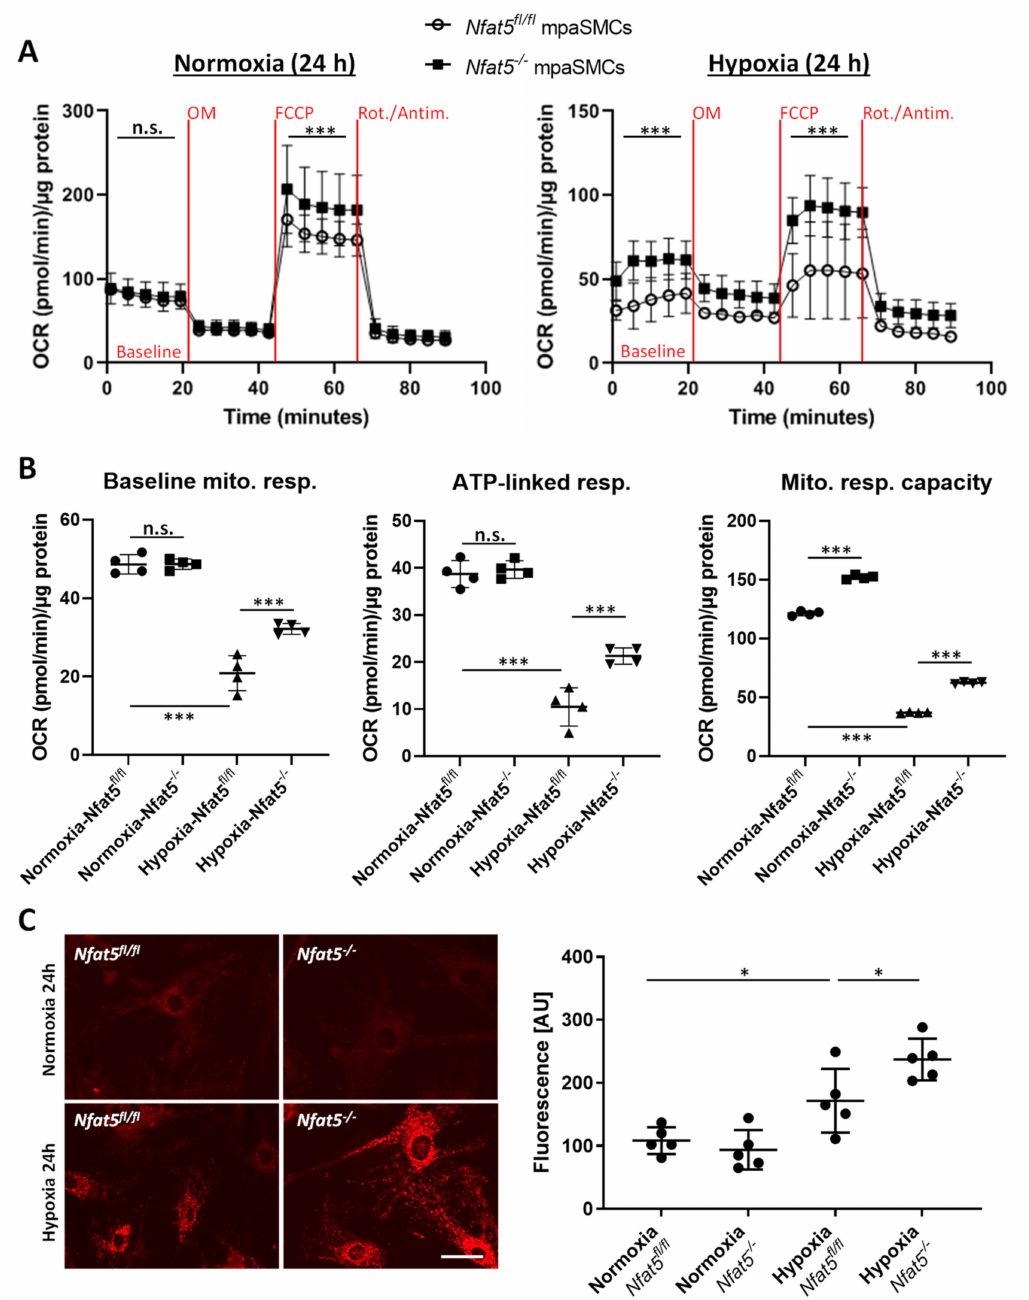
Figure 6. Functional analysis of hypoxia-exposed mpaSMCs. Mitochondrial respiration was assessed by analysis of the oxygen consumption rate (OCR) using a Seahorse XF analyzer. mpaSMCs were treated with an adeno-associated virus to overexpress CRE recombinase ( Nfat5 − / − ) or GFP ( Nfat5 fl/fl ) and exposed to normoxia/hypoxia for 24 h prior to the analysis. ( A ) OCR was assessed while treating the cells with oligomycin (OM, complex V inhibitor), FCCP (protonophore), and rotenone/antimycin A (Rot/Antim., complex I/III inhibitors) and normalized to the total cellular protein per sample (*** p < 0.001 vs. Nfat5 fl/fl , 2-way ANOVA Š í d á k’s multiple comparisons test, three replicates were performed for each sample, note that some error bars were smaller than symbols, see Figure S8 for further results. ( B ) Results for baseline respiration, ATP-linked respiration, and maximal mitochondrial respiratory capacity (*** p < 0.001 as indicated). ( C ) Mitochondrial ROS production was assessed by recording the fluorescence intensity of a ROS-sensitive mitochondrion-selective probe (red) in Nfat5 -deficient ( Nfat5 − / − ) or control ( Nfat5 fl/fl ) mpaSMCs, exposed to hypoxia for 24 h (* p < 0.05 as indicated, one out of three experiments performed in pentaplicate, scale bar: 50 µ